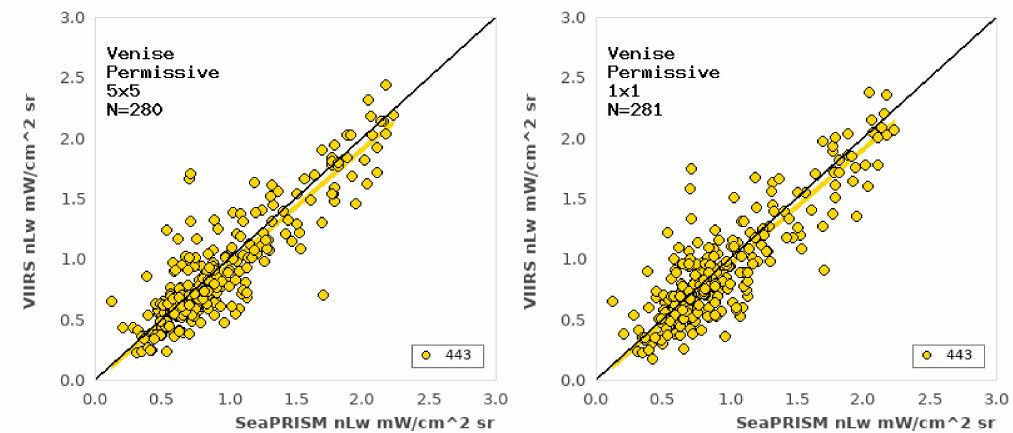
Figure 6. Venise–VIIRS comparison, June 2014 − May 2019. Permissive protocol. Left: 443 nm 5 × 5 box mean; right: center (in situ) pixel only. This is the only wavelength in which the 5 × 5 box has statistics closer to the 1:1 line than the center pixel